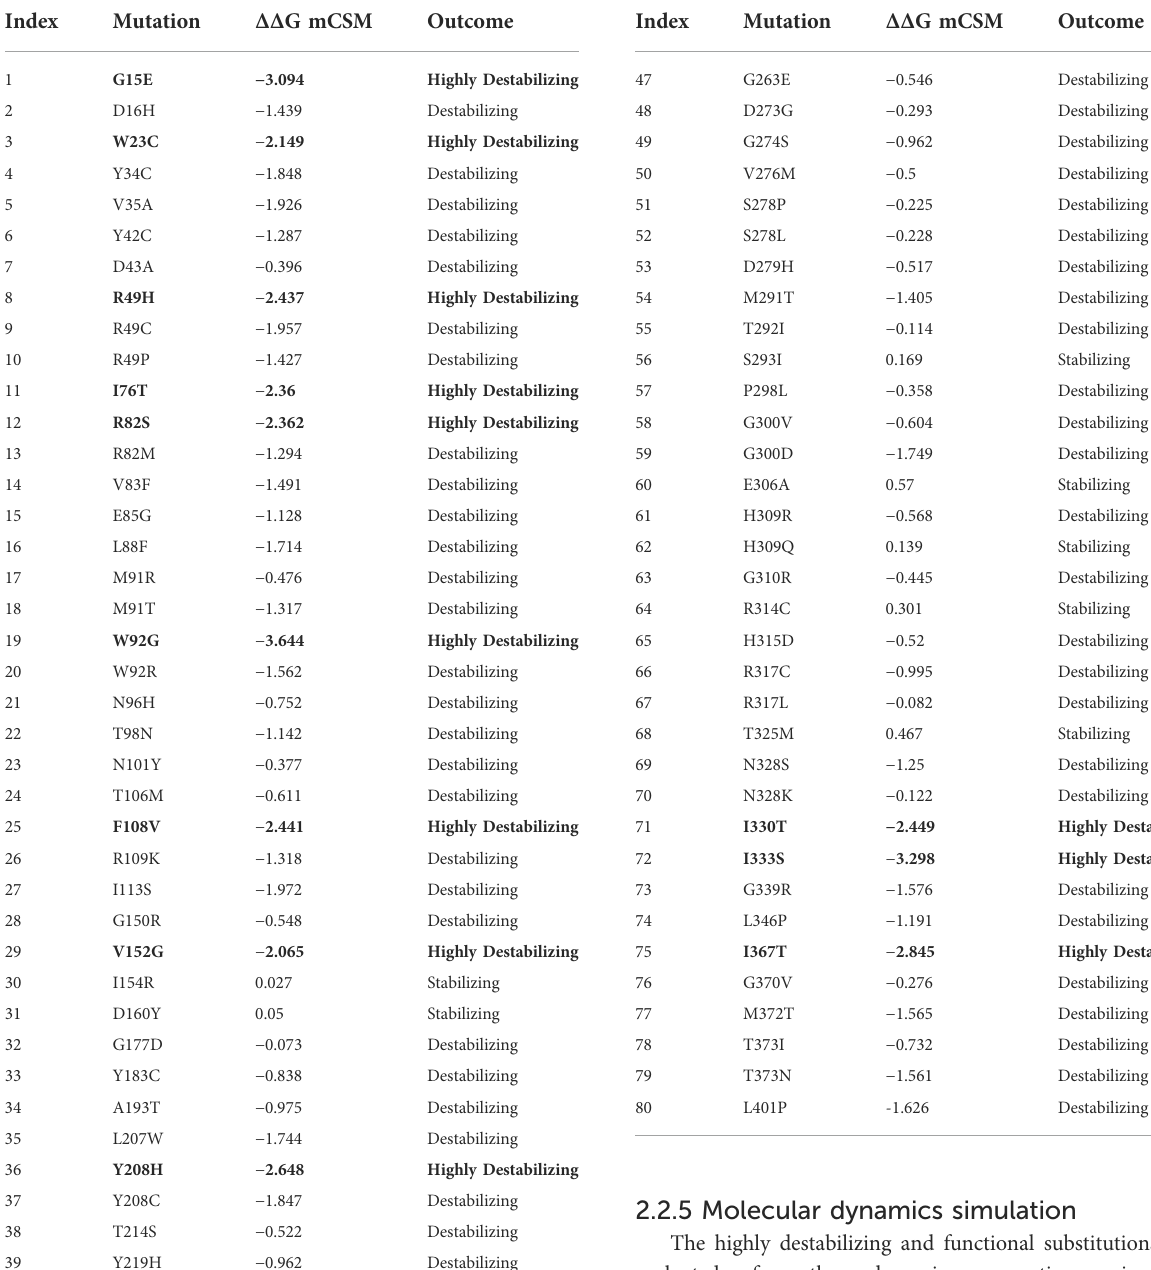
TABLE1Listofhighly deleterious anddestabilizing mutations inIDH1. Among the 80 mutations, 14 highly destabilizing ones are shown in